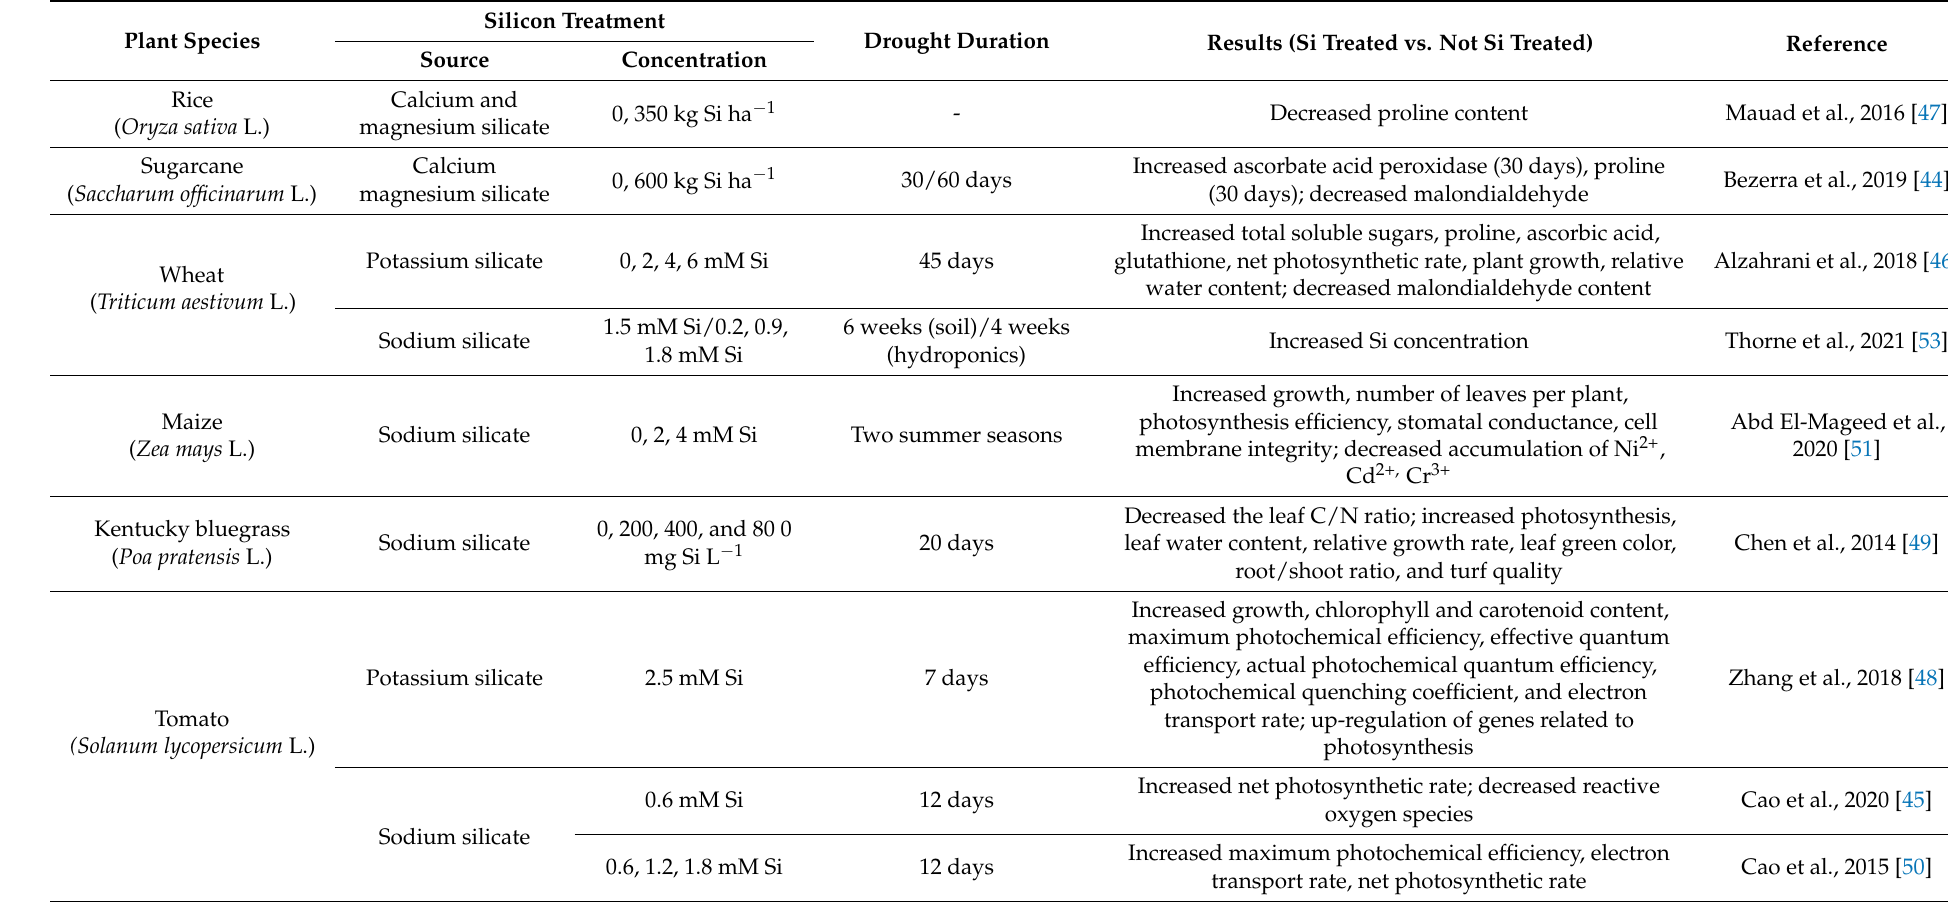
Table 1. Overview of studies on the relationship between drought and silicon